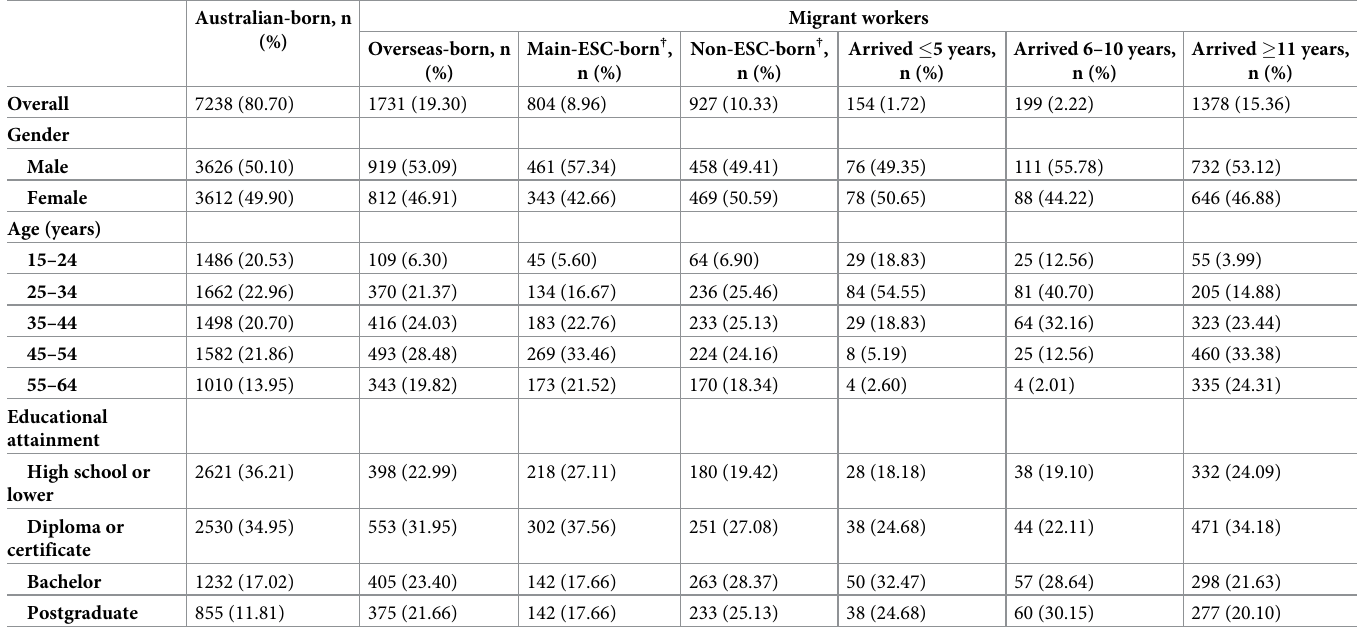
Table 1. Descriptive statistics on socio-demographic characteristics by migrant status (n = 8969).